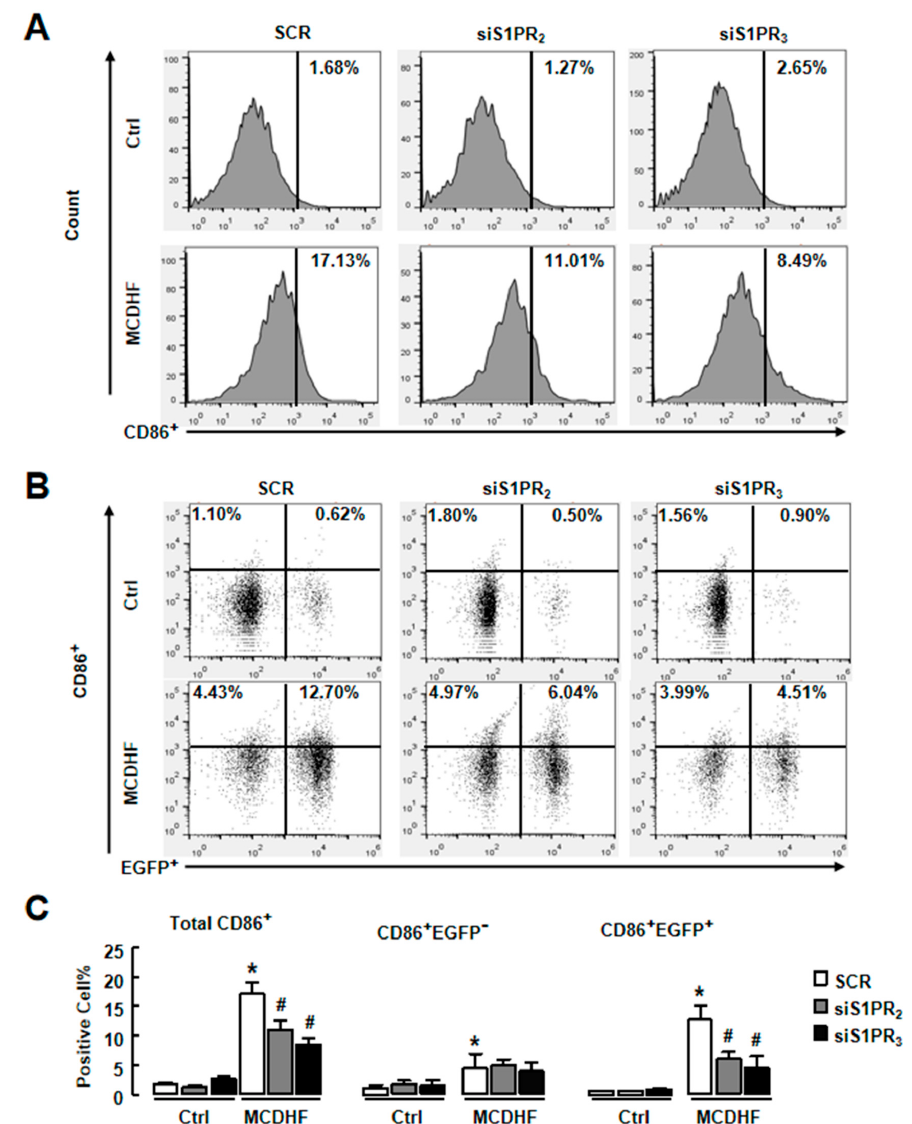
Figure 7. S1PR 2/3 knockdown decreased iM φ recruitment in MCDHF-diet-fed mouse model. Liver NPCs were isolated from SCR- and siS1PR 2/3 -treated mice after 14 days of control or MCDHF diet feeding. FACS was performed on these cells. ( A ) The percentage of total iM φ detected by FACS in the liver. ( B ) The percentage of pro-inflammatory BMMs or pro-inflammatory KCs in the liver. ( C ) Quantification of these cell components. Data are presented as the mean ± SEM. * p < 0.05 versus the control group. # p < 0.05 versus the MCDHF diet group ( n = 6 for each group in each experiment). SCR, scramble